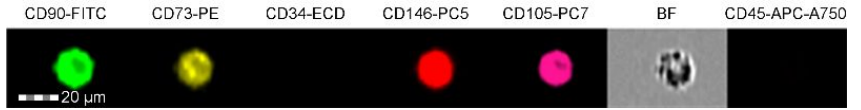
Figure 1. Expression of CD73, CD90, CD105, and CD146 surface antigens in Wharton’s jelly stem cells. Cytometric analysis carried out on a MoFlo XDP cell sorter (Beckman Coulter). Analysis of minimum 10,000 events was recorded for each probe.